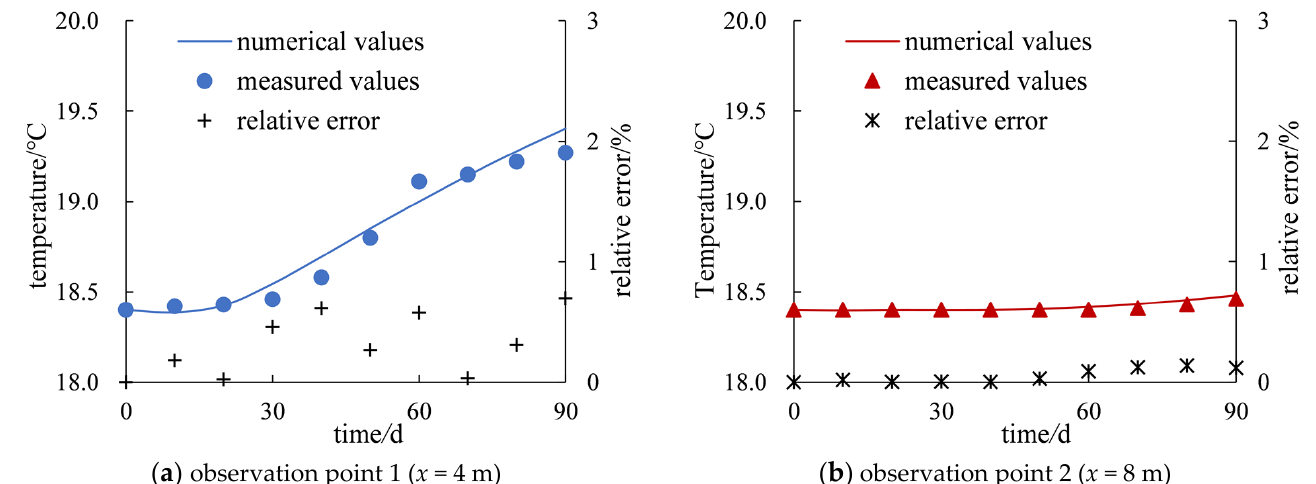
Figure 7. Comparison of numerical and measured temperature values of the observation points during the refrigeration period.